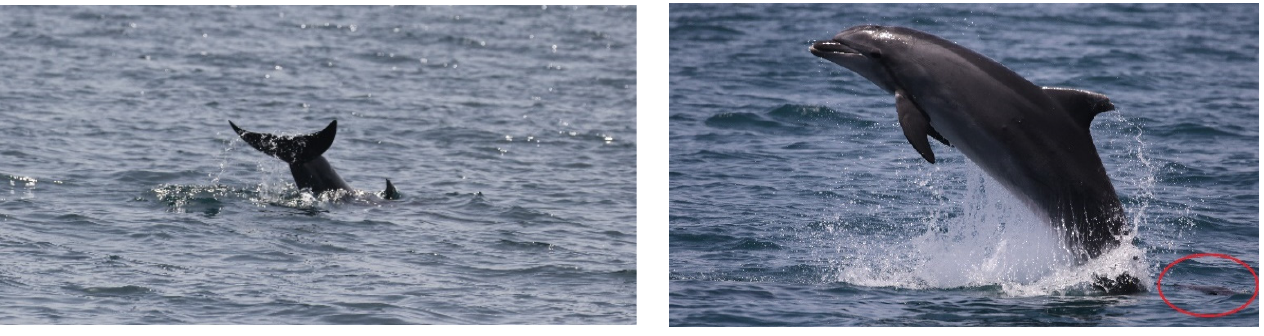
Figure 5. Tail slap ( left picture) and leaping close to the carcass (red circle) exhibited by the escort individual “B” ( right picture) .